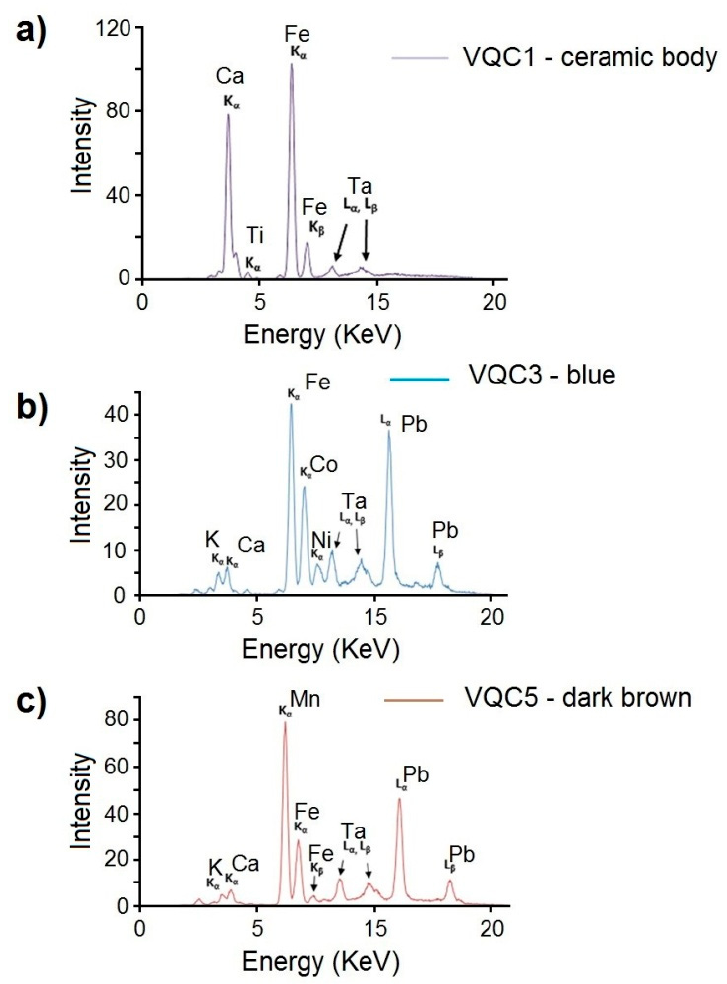
Figure 4. Representative XRF spectra collected on the ( a ) ceramic body of the VQC1 sample, ( b ) blue area of the VQC3 sample, and ( c ) dark-brown area of the VQC5 sample. Looking at the elemental composition collected at the yellow area of the glazed surface of sample VQC3, the detection of elements such as Pb, Sn, and Sb indicate the use of lead (II) antimonate or lead tin yellow pigments [45]. However, since Sn is also present in the glaze as an opacifier (SnO 2 ), XRF analysis alone cannot unambiguously identify the yellow pigment used [46]. The presence of Mn and Fe at dark-brown decorations, only present in sample VQC5, suggests the use of earth pigments, most likely umber (iron oxide with about 6–15% of MnO 2 + clay + silica) [47]. In addition, XRF analyses identified the use of copper (Cu) at green decorations in samples VQC2 and VQC4, and iron (Fe) as the chromophore element responsible for the orange areas of VQC1 and VQC2 shards. Finally, as far as the ceramic body is concerned, calcium (Ca) and iron (Fe) were the main chemical elements detected, certainly due to the mineralogical phases constituting the ceramic